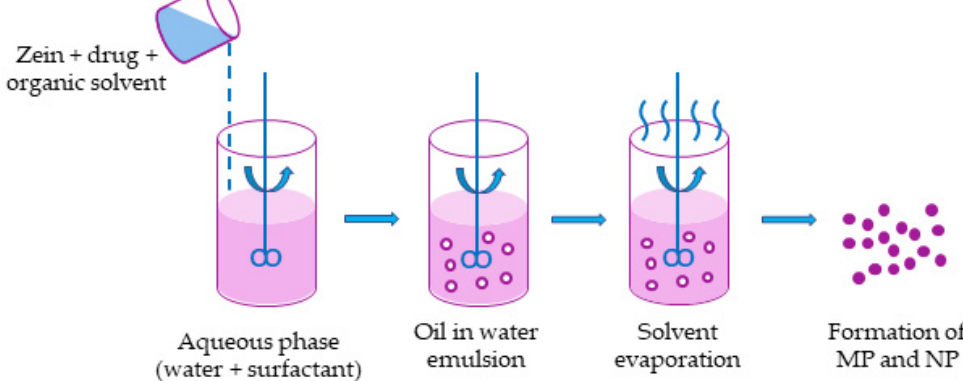
Figure 5. Schematic representation of emulsification followed by solvent evaporation. For example, aceclofenac sodium, a nonsteroidal anti-inflammatory drug used exten- sively in treating rheumatoid arthritis and osteoarthritis, was processed with this tech- nique [124]. The disperse phase was prepared by dissolving the drug and zein in 90% alcohol. This solution was added to the continuous phase (sesame oil) containing 0.5% Span 80 as an emulsifying agent. MPs with an MD in the range of 136–174 µ m were obtained; the EE varied from 11.6 to 26.1% depending on the zein/drug ratio. In vitro release studies were attempted simulating gastric and intestinal fluids: a sustained release up to 72 h was detected. Biocompatibility of the zein microspheres was evaluated through in vitro cytotoxicity studies using fibroblast cells from the explant tissue. Karthikeyan et al. [125] used the same method to prepare zein microspheres charged with aceclofenac, metformin, and promethazine. The three active principles were chosen as examples of hydrophobic, hydrophilic, and amphiphilic drugs. The average particle size of the different zein/API microspheres was found to be 68–136 µ m depending on the drug. The EE was around 20–25% depending on the zein/API ratio. The higher the ratio, the higher the EE. A novel approach proposed by some authors is the preparation of zein microstructures by electrospinning and spray-drying (SD). For example, Coelho et al. [126] incorporated vitamin B12, the most chemically complex and the largest molecule among all the vitamins, into zein. The microparticles obtained by electrospinning had a size of around 3 µ m and